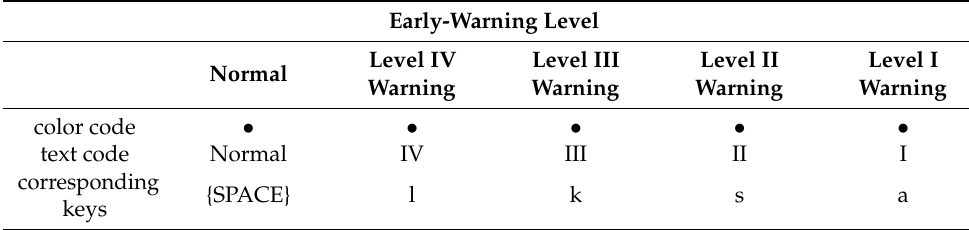
Table 1. Experimental materials.